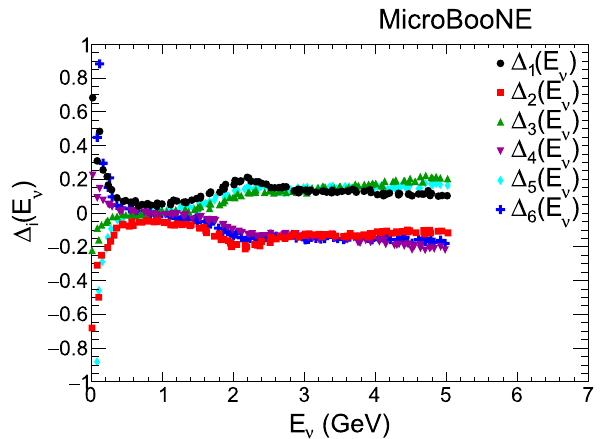
Fig. 10 Beam flux shifts for the parameterizations (cid:11) i ( E ν ), i = 1 − 6. The variations (cid:11) 1 ( E ν ) and (cid:11) 2 ( E ν ) define the envelope of flux uncer- tainties for the BNB